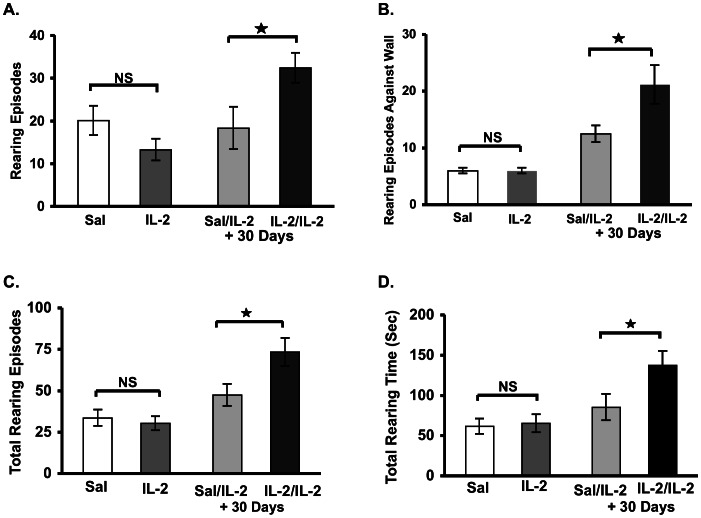
Administration of IL-2 in adults increases rearing behavior (in contrast to periadolesence).Mean (± S.E.M.) activity scores (A. Number of rearing episodes within 3 sec; B. Number of rearing against wall episodes within 3 sec; C. Total number of rearing episodes; D. Total time spent rearing (sec)) following a single injection of saline or IL-2 (0.4 µg/mouse, s.c.) and those tested 30 days later with single injection of IL-2 (0.4 µg/mouse, s.c.) administered 30 days later, as described in the figure with “+30 days” designation. Mice were exposed to the test cage immediately following cytokine administration. *p<0.05.